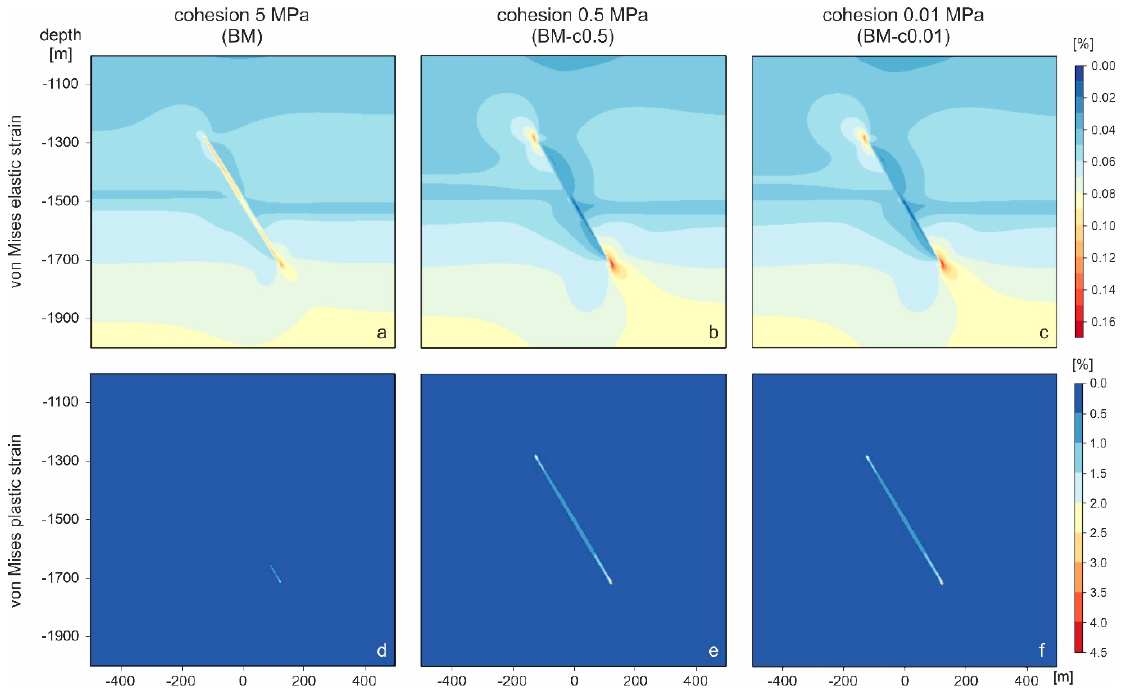
Figure 9. Spatial variations in the van Mises elastic ( a – c ) and plastic strain ( d – f ) after five years of injection for three different cohesion values assigned to the fault